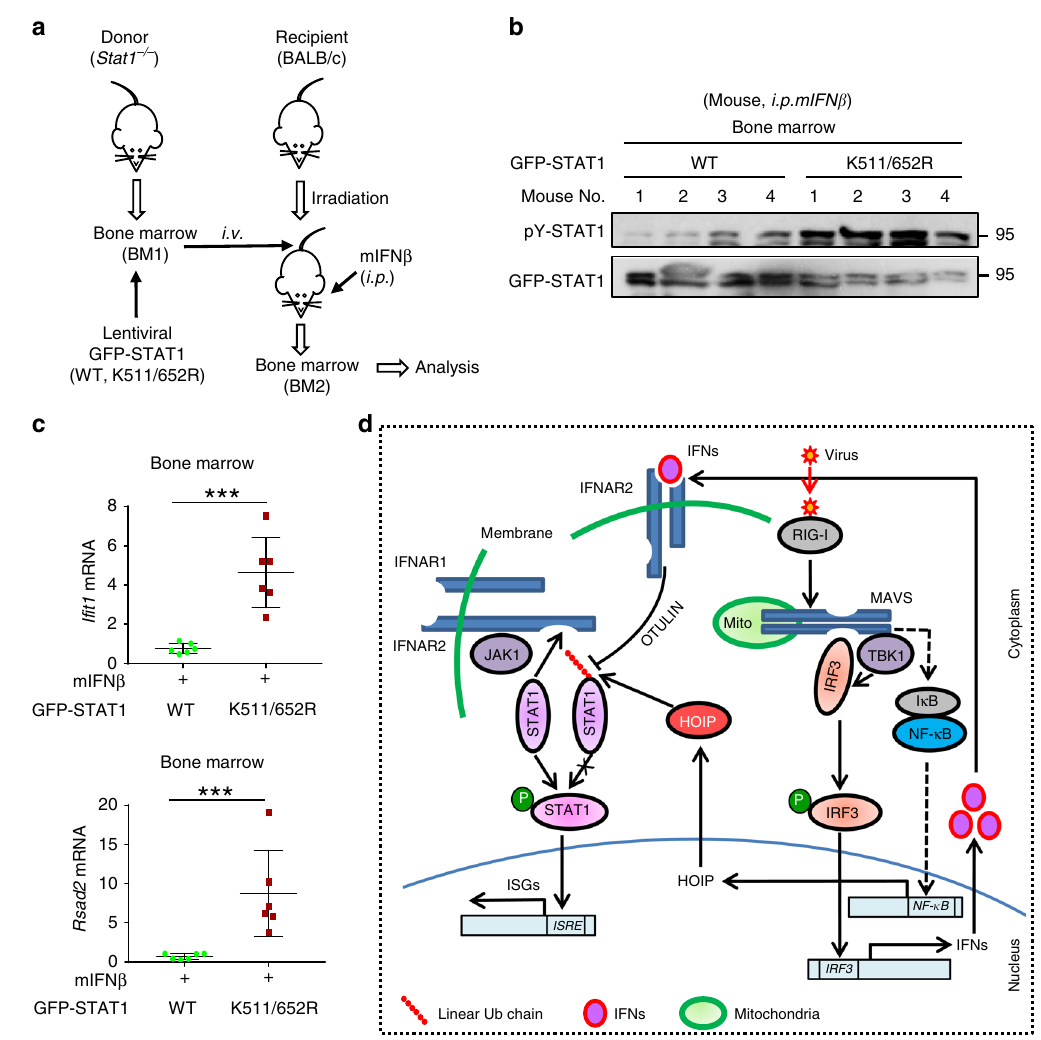
Fig. 8 STAT1-K511/652 mutation enhances IFN-I antiviral activity. a Diagram of bone marrow chimeras using wild-type BALB/c mice as recipients and Stat1 − / − (129S6) mice as donors. b The bone marrow was obtained from BALB/c mice that were irradiated and injected (i.v.) with the Stat1 − / − bone marrow with lentiviral packaging GFP-STAT1 (WT or K511/652 R), followed by administration with mIFN β (1500 IU/g, i.p.) for 8 h. Immunoprecipitation and western blot were performed to analyze pY701-STAT1 and GFP-STAT1 levels. c RT-qPCR analysis of the representative ISGs ( I fi t1 and Rsad2 ) mRNA in the bone marrow from recipient mice treated as b . d Linear ubiquitination of STAT1 restricts the interaction between STAT1 and IFNAR2, thus inhibiting STAT1 activation and maintaining homeostasis of IFN signaling. Viral infection rapidly induces production of IFNs, which utilize OTULIN to remove linear ubiquitination of STAT1, thus promoting STAT1 activation. During the late stage of viral infection, HOIP expression is upregulated through the NF- κ B signaling pathway, which increases STAT1 linear ubiquitination and inhibits host IFN antiviral response. *** p < 0.001 (two-tailed unpaired Student ’ s t test). All graphs show the mean ± SEM for six individual mice ( c ). Data are representative of three independent experiments ( b